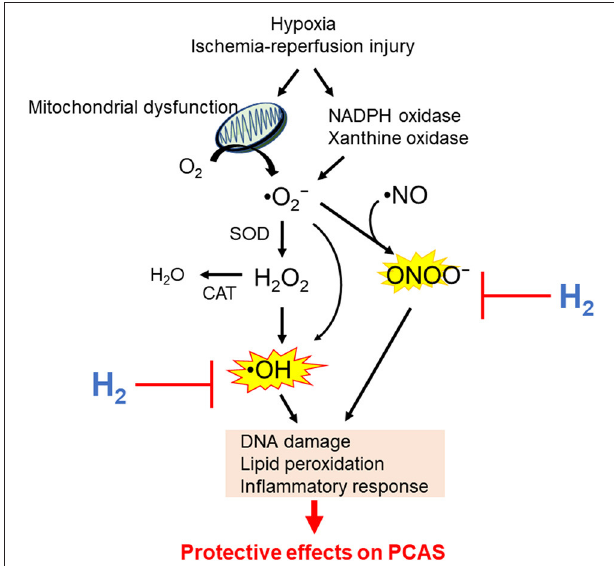
FIGURE 3 | Potential mechanisms by which hydrogen (H 2 ) inhalation improves outcomes in post–cardiac arrest syndrome (PCAS). NADPH, nicotinamide r adenine dinucleotide phosphate; O 2 − , superoxide anion radicals; H 2 O 2 , r hydrogen peroxide; OH, hydroxyl radical; ONOO − , peroxynitrite; oxide; SOD, superoxide dismutase; CAT,